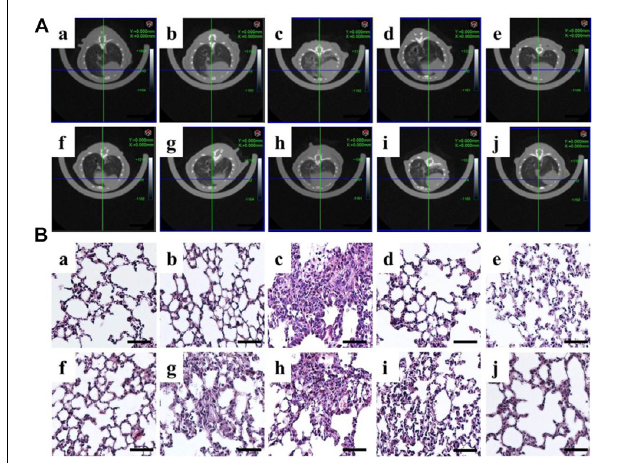
FIGURE 1 | Correlation of in vivo µ CT imaging with lung pathology in bleomycin-induced pulmonary fibrosis. (A) µ CT scan and (B) H&E staining of mouse lungs from a, normal; b, sham; c, model; d, DLP low; e, DLP medium; f, DLP high; g, DHP low; h, DHP medium; i, DHP high; j, ROS. Scale bar = 50 µ